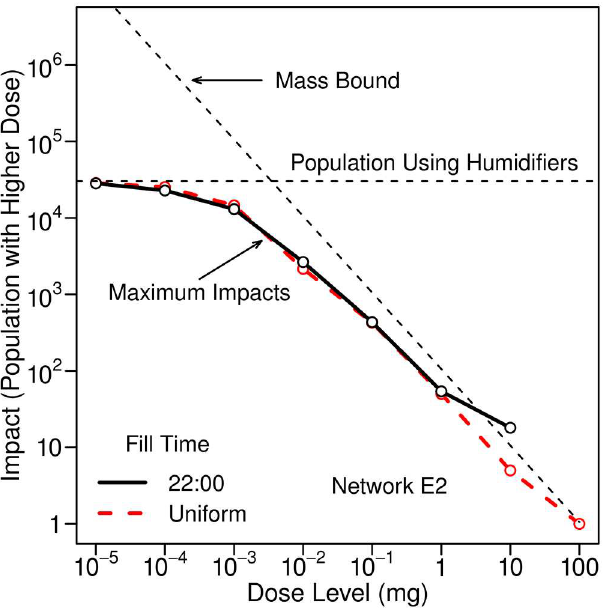
Fig 15. Example of bounds on inhalation impacts associated with humidifier use. Results are for aerosols for Network E2 and 10 kg of contaminant injectedat 0:00 hours. Twenty per cent of the populationis assumed to use ultrasonic humidifiersfor eight hours each day, with fill times either at 22:00 hours or uniformly distributed from 06:00 to 23:30